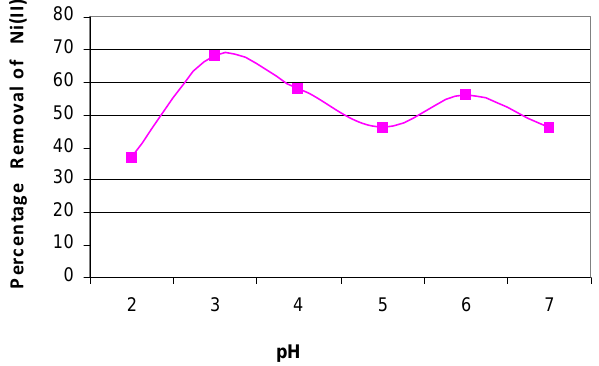
Figure 1: Effect of pH on the biosorption of Ni(II)